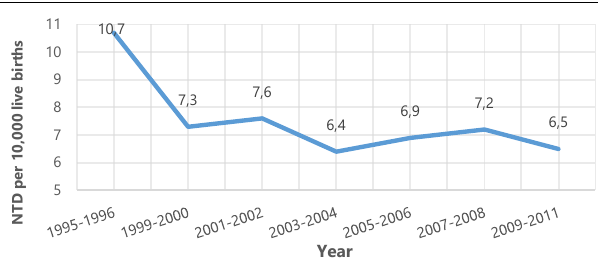
Figure 1 . Prevalence of Neural Tube Defects (NTD) per 10,000 Live Births in the United States from